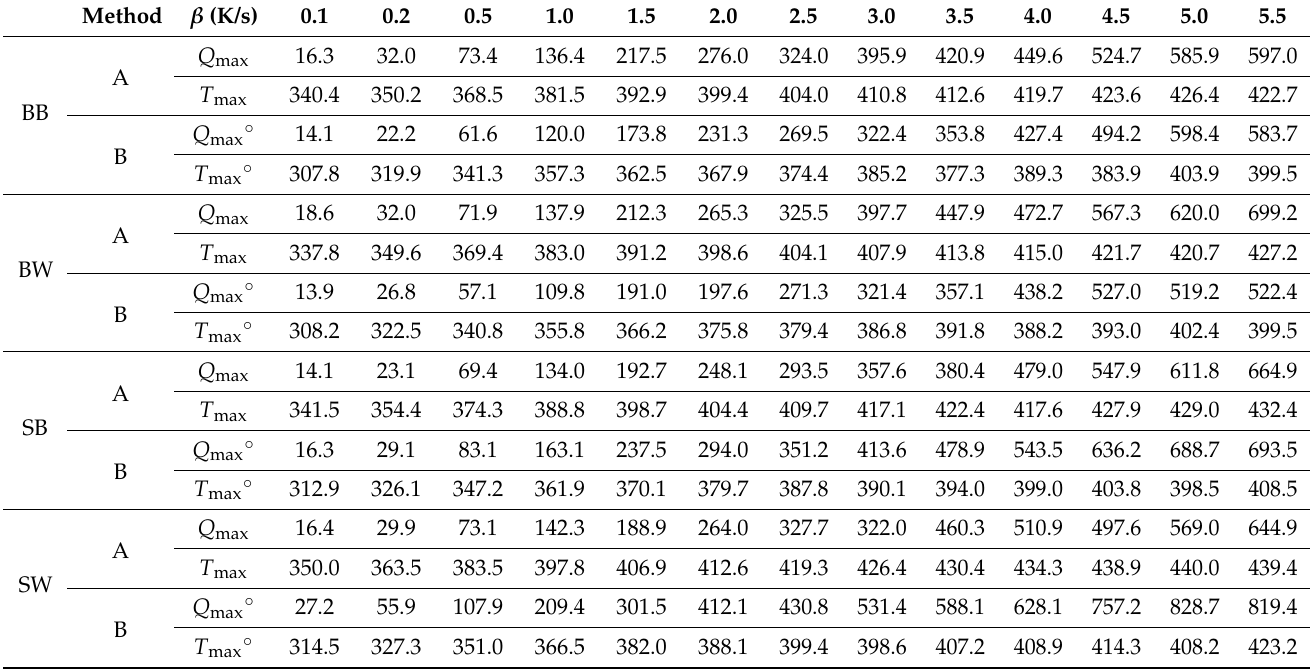
Table 2. Maximum specific heat release rate Q max and maximum specific combustion rate Q max ° (W/g) with corresponding temperature T max , and T max ° (°C).